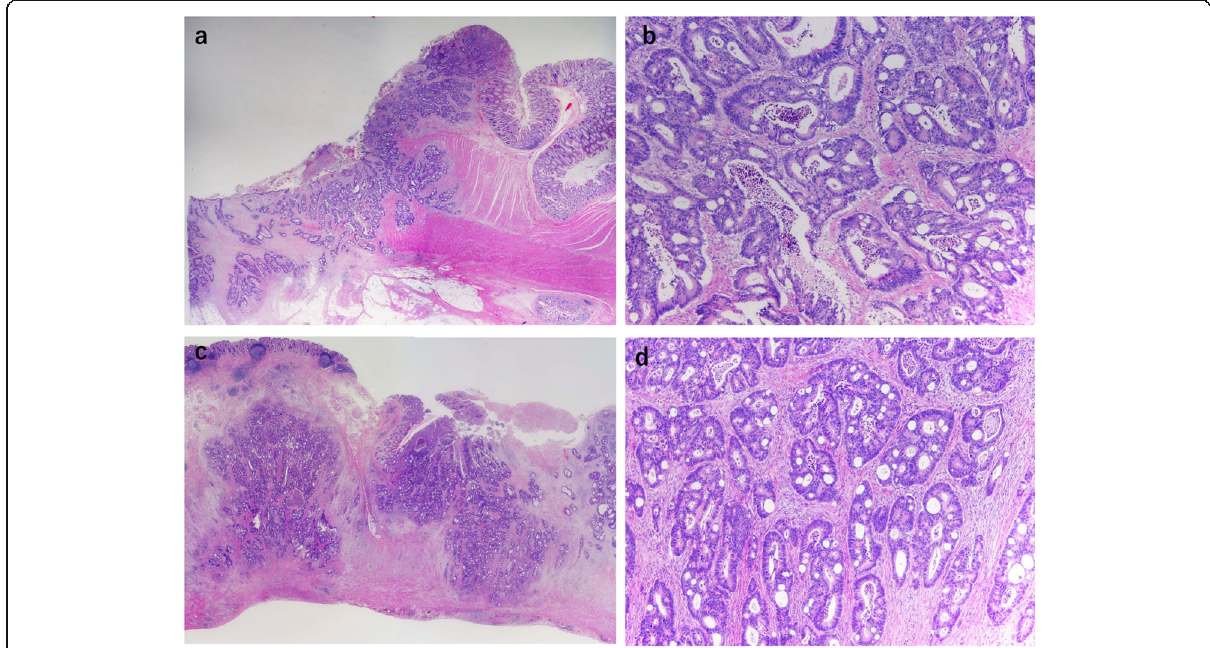
Fig. 3 Histopathological findings (hematoxylin and eosin). a The mucosa between the primary ascending colon cancer and the appendix is normal (×1). b The primary colon cancer was moderately differentiated adenocarcinoma (×4). c Cancer cells are seen mainly in the submucosa and muscularis propria of the appendix. d Moderately differentiated adenocarcinoma cells similar to those seen in the ascending colon cancer